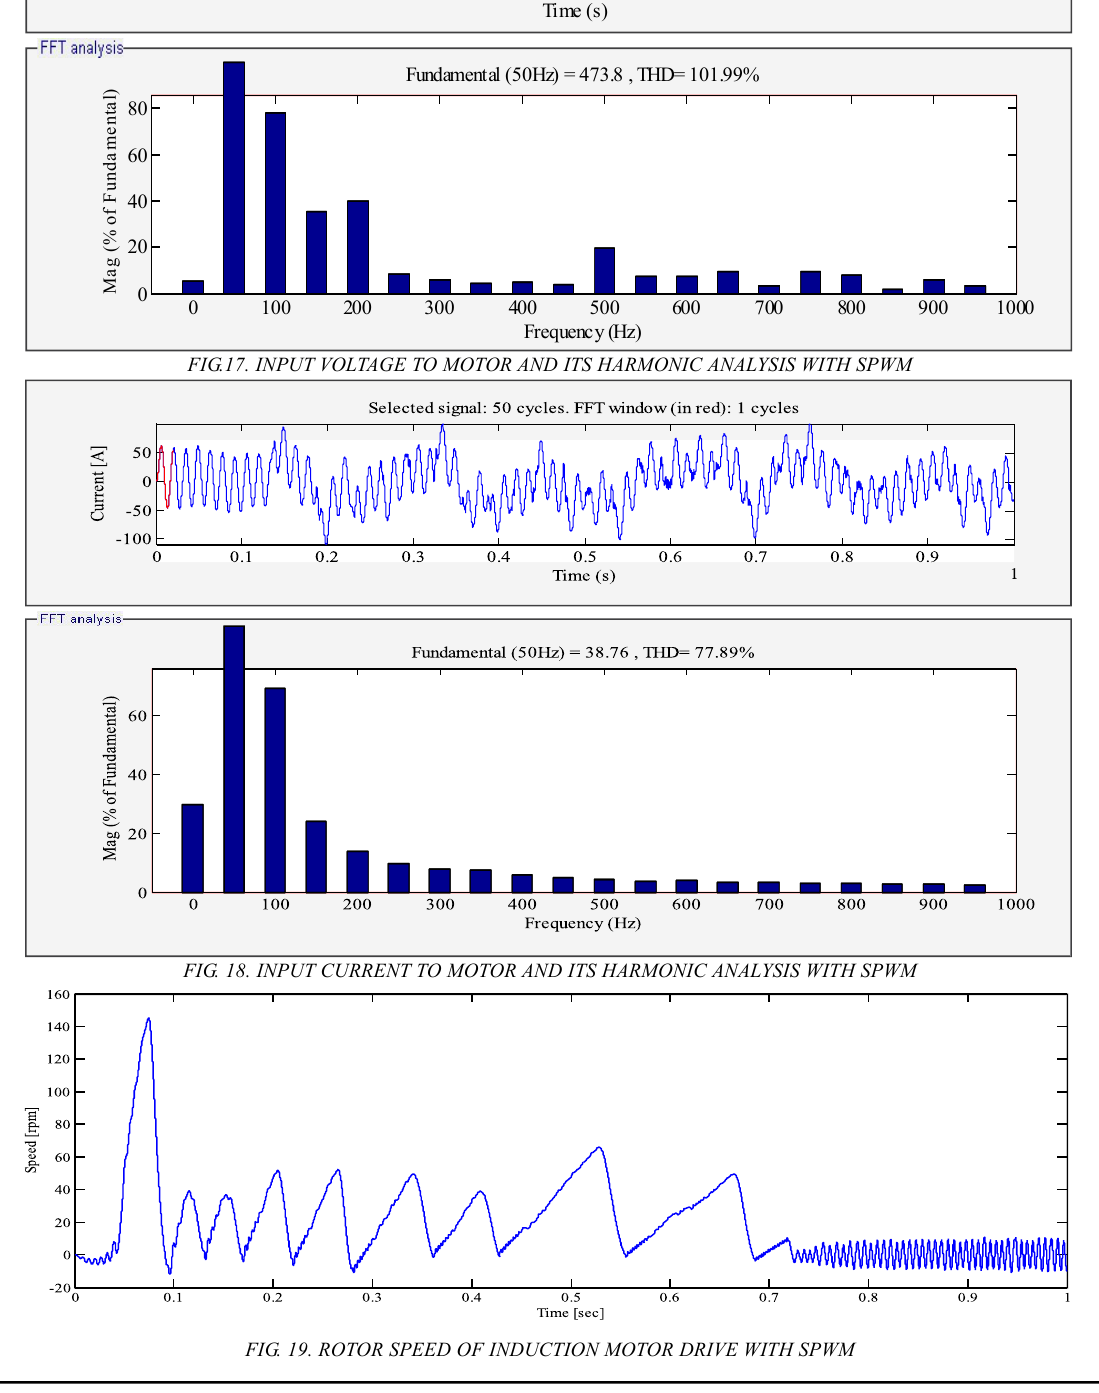
FIG. 19. ROTOR SPEED OF INDUCTION MOTOR DRIVE WITH